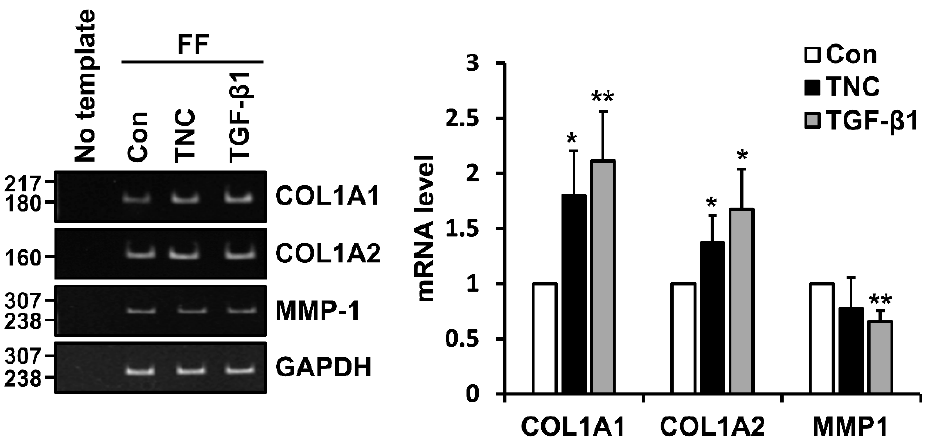
Figure 3. Effect of TNC on the levels of type I collagen and MMP-1 mRNAs in human fibroblasts. Serum-starved human foreskin fibroblasts (FF) were incubated without (Con) or with TNC (2 µg/mL) or TGF- β 1 (3 ng/mL) for 12 h. Levels of COL1A1 , COL1A2 , and MMP-1 mRNAs were evaluated by conventional (left) and quantitative (right) RT-PCR analyses. Each value represents the mean ± SD of five independent experiments. * p < 0.05, ** p < 0.01 vs. Con.